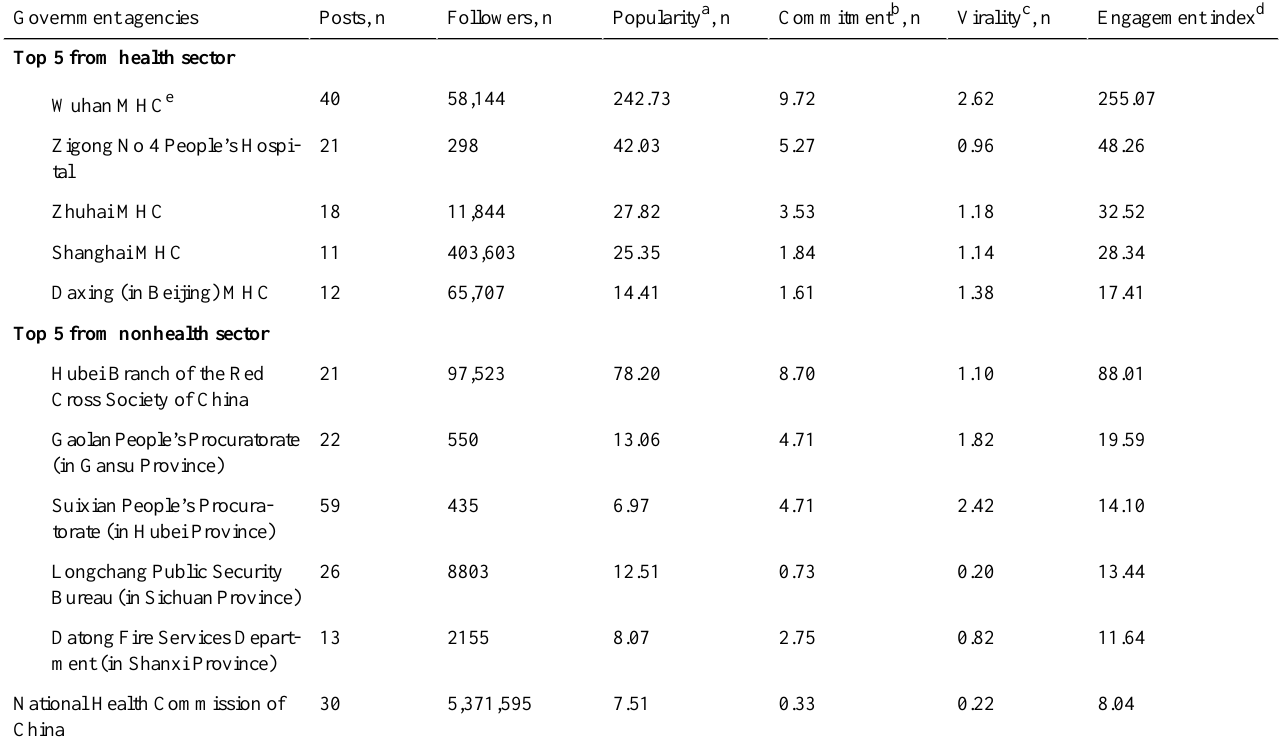
Table 1. Government agencies with the greatest engagement and associated engagement metrices for coronavirus disease communications